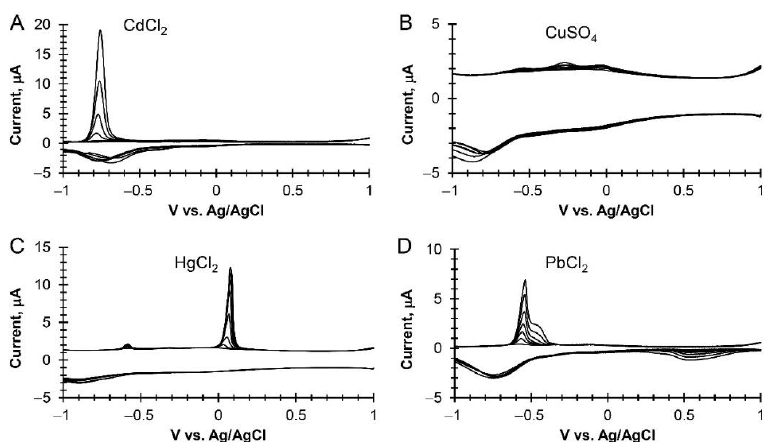
Figure 5. Examples of cyclic square wave voltammograms and the dose–response of heavy metal salts in seawater between 0 to 3 ppm. ( A ) CdCl 2 at oxygen modified multilayer EG. ( B ) CuSO 4 at unmodified multilayer EG. ( C ) HgCl 2 at unmodified hydrogen-intercalated QFS bilayer EG. ( D ) PdCl 2 at oxygen modified hydrogen-intercalated QFS bilayer EG.